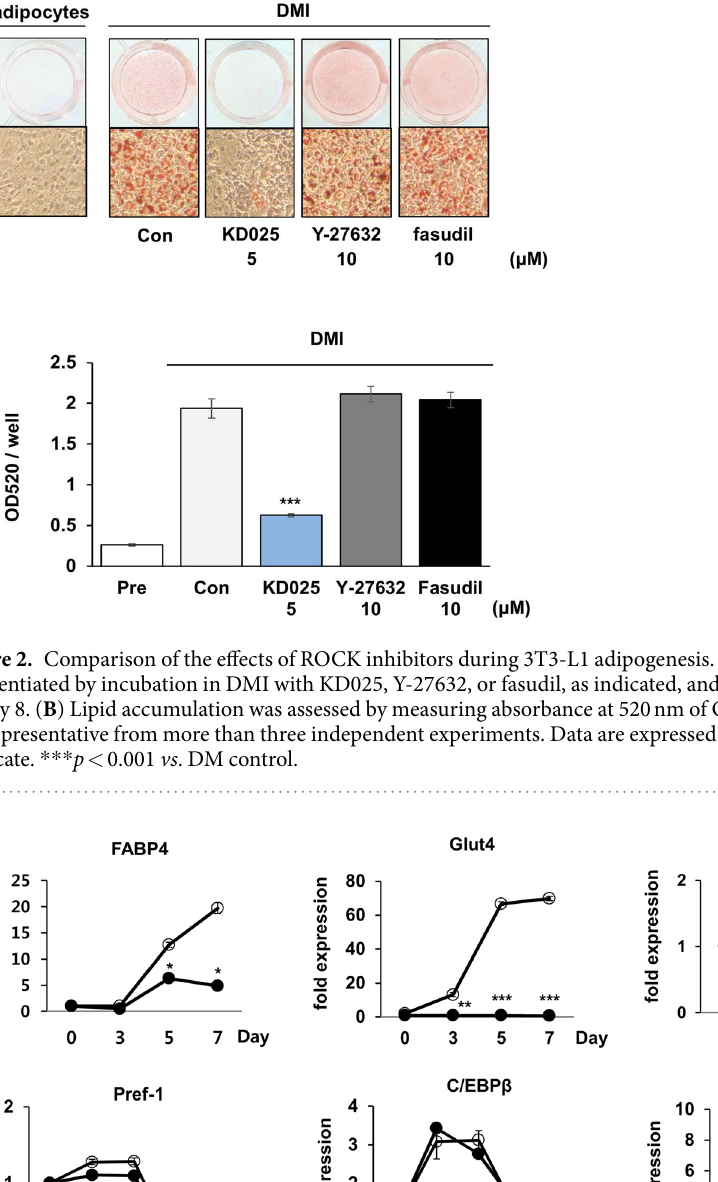
To confirm that the Akt-inhibitory effect of KD025 depends on normally-fed cells, we treated three different cell lines with this compound for 1 day in normal conditions (10% FBS) without any starvation/insulin stimula- tion intervention and examined Akt phosphorylation by immunoblotting. Normally cultured cells (3T3-L1, L6,